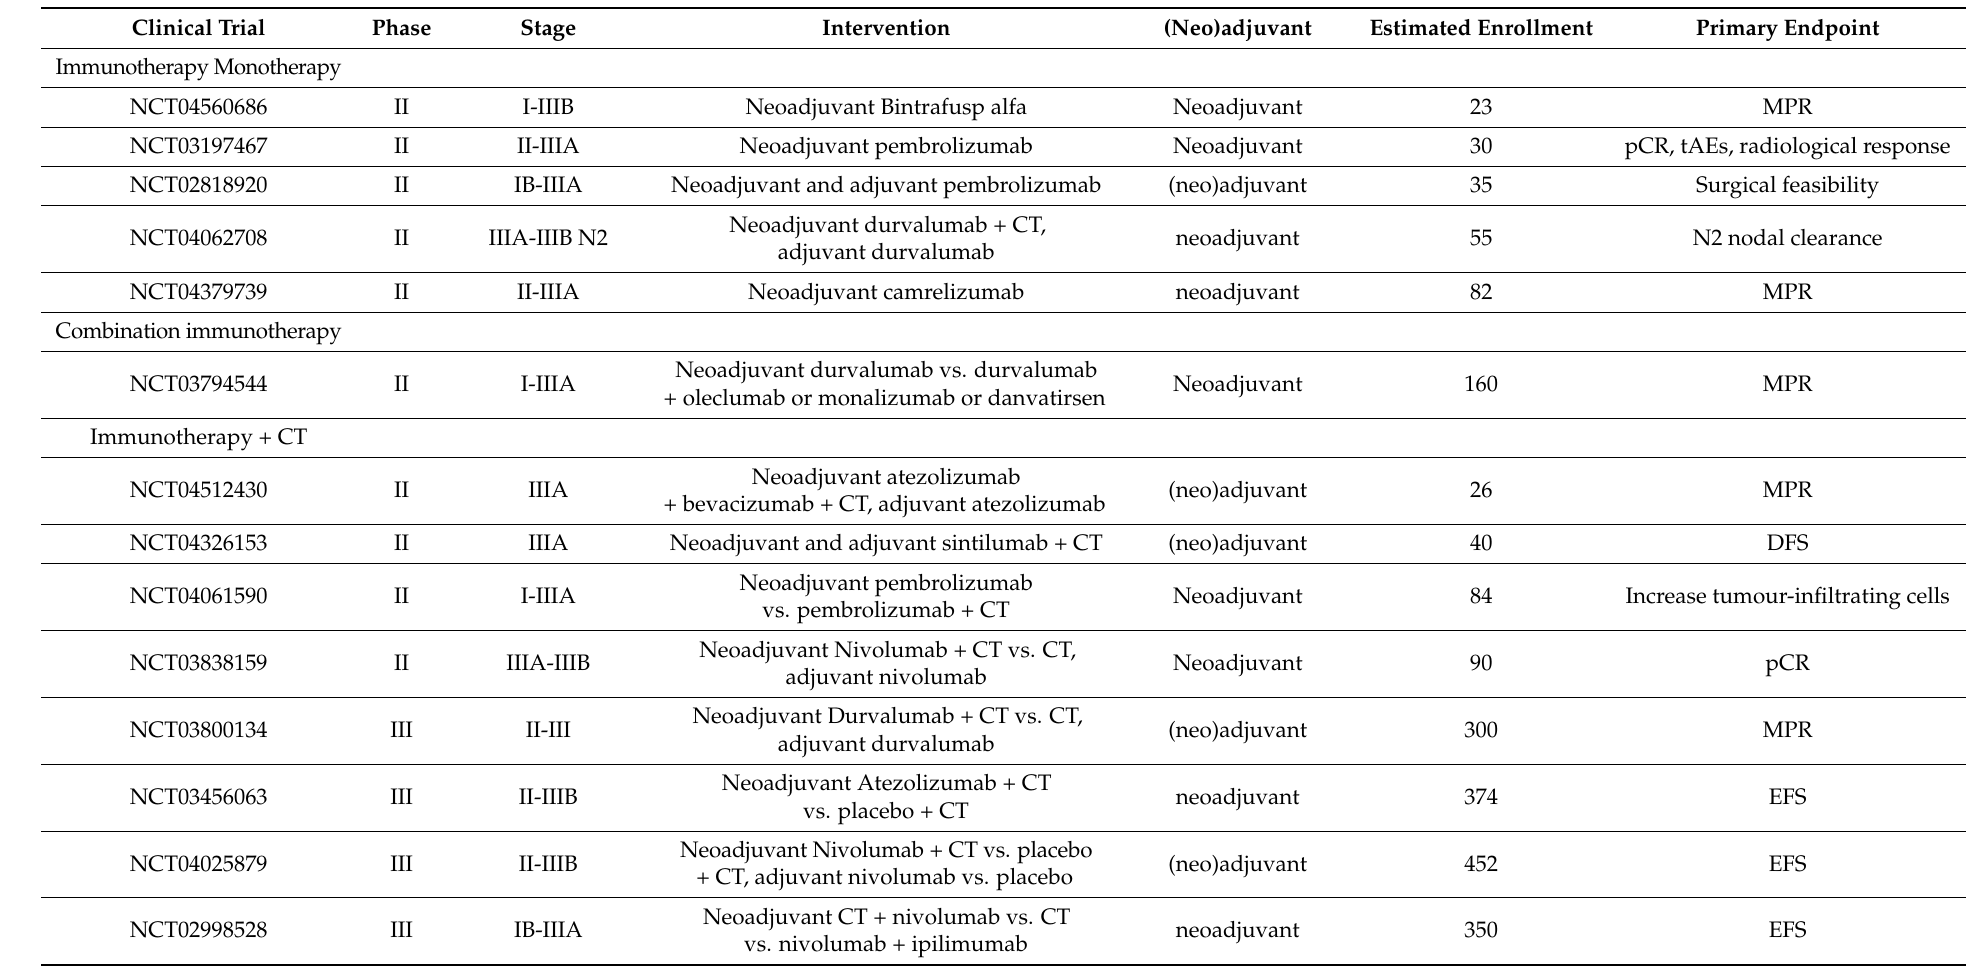
Table 1. Ongoing trails on neoadjuvant immunotherapy and targeted therapies for resectable NSCLC, including stage